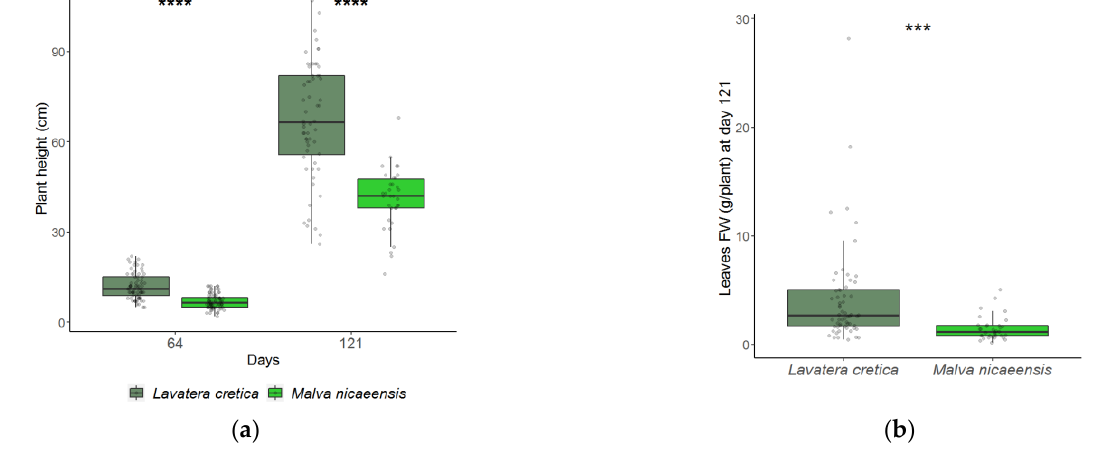
Figure 1. Development of L. cretica and M. nicaeensis in experimental open field (2019 – 2020). ( a ) Plant height 64 days and 121 days after sowing; ( b ) Leaf FW per plant 121 days after sowing. Each dot represents an individual plant; dots are distributed horizontally for visual clarity. *** and **** indicates p -value ≤ 0.001 and p -value ≤ 0.0001, respectively.